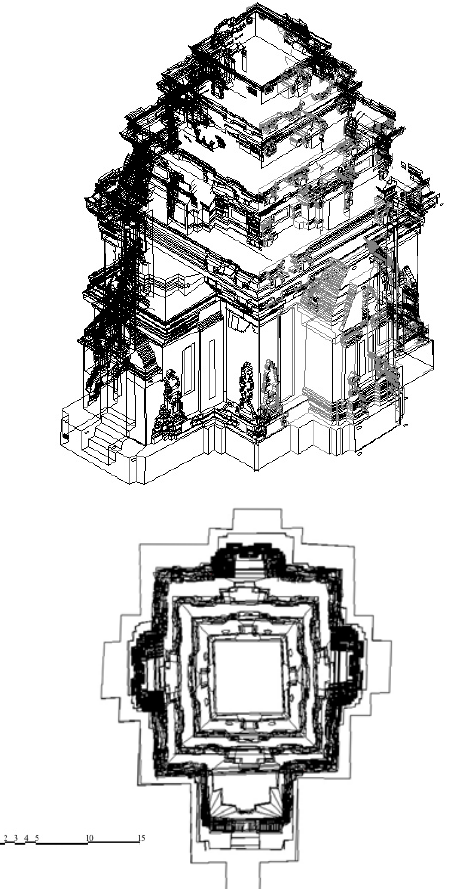
Figure 7. Hoa-Lai West tower axonometric view and plan